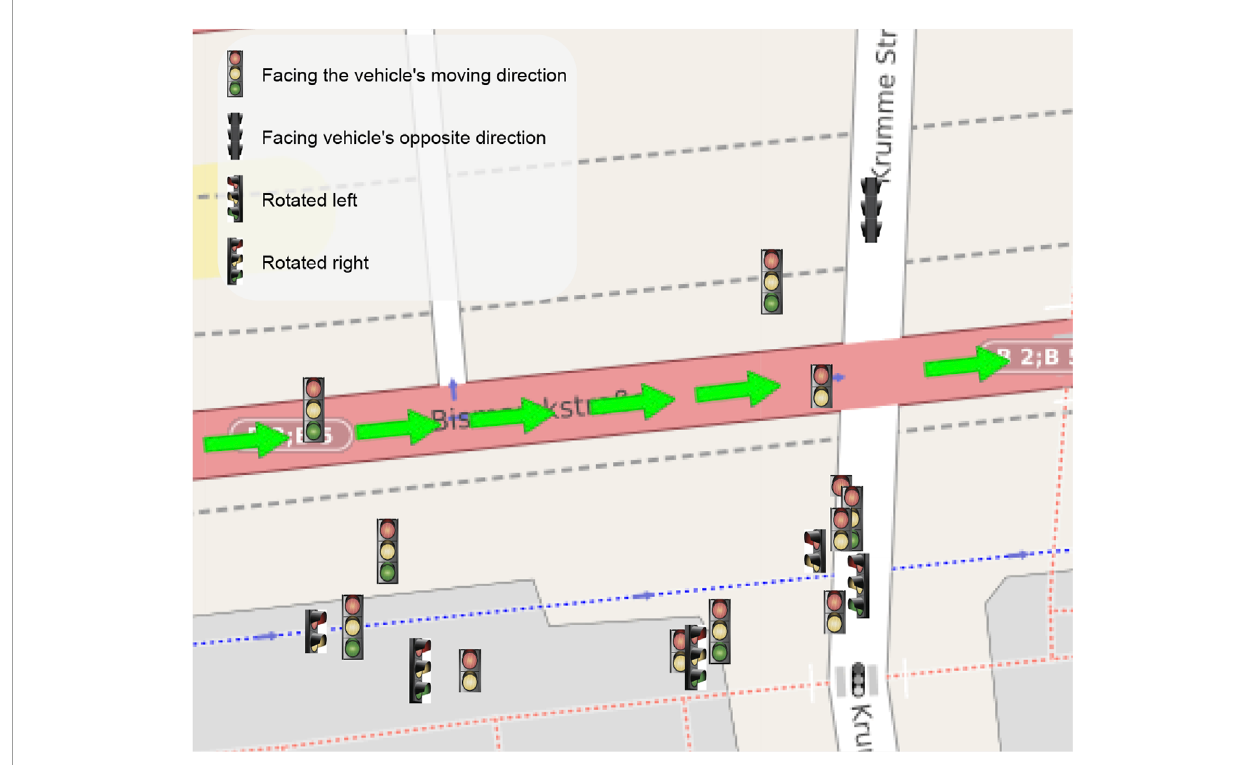
FIGURE 5 Map obtained from the pipeline on a sequence in the DTLD test set acquired on a complex junction in Berlin center (the green arrows represent the car trajectory). Close markers represent multiple lights mounted on the same pole, such as pedestrians, cyclists, buses, or tram lights. A slight offset has been applied to excessive close light for visualization purposes. The represented area is a small section of the whole 4 lanes